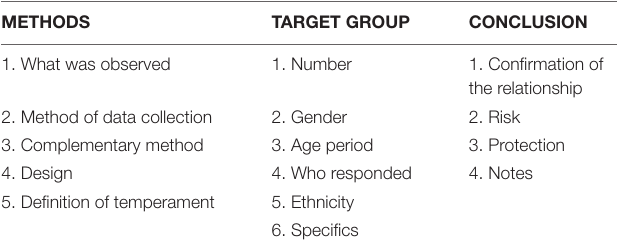
TABLE 1 | Qualitative